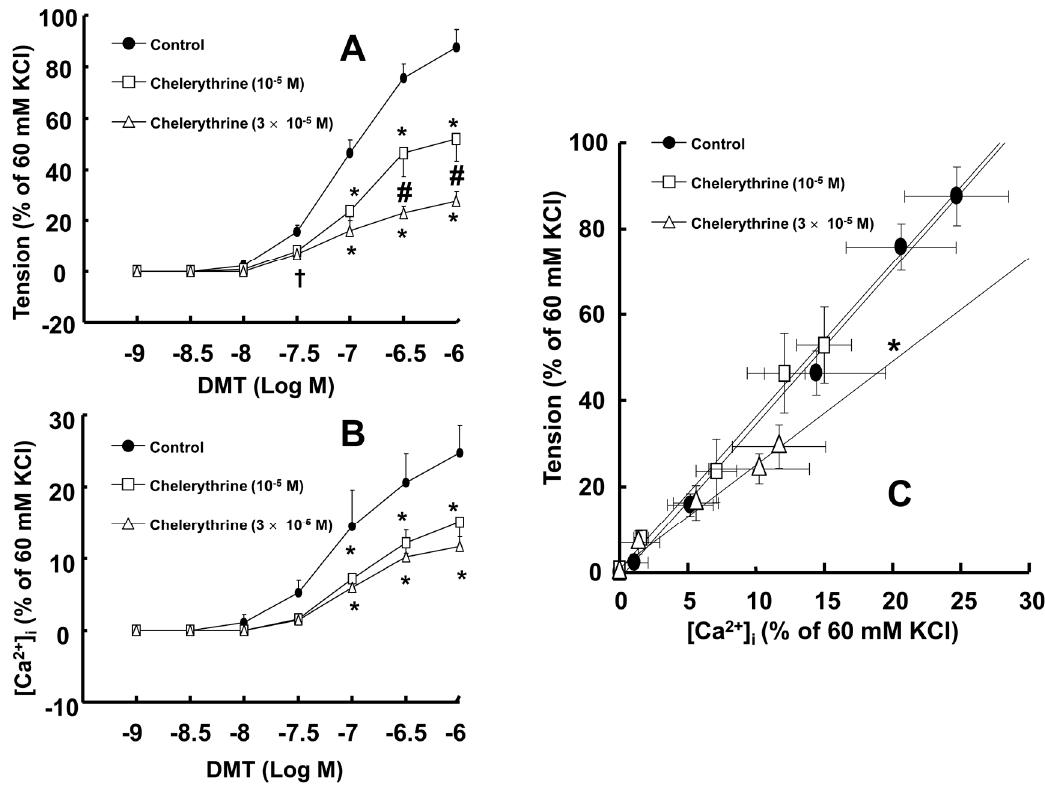
Figure 3. Effects of the cumulative addition of dexmedetomidine (DMT, 10 − 9 to 10 − 6 M) on muscle tension ( A ) and intracellular calcium concentrations ([Ca 2+ ] i ) ( B ) in the absence or presence of 10 − 5 M or 3 × 10 − 5 M chelerythrine in endothelium-denuded rat aortas. A value of 100% represents the 60 mM KCl-induced [Ca 2+ ] i increase and muscle tension measured before washout with Krebs solution; ( C ) The [Ca 2+ ] i -tension relationship was constructed by the cumulative addition of DMT (10 − 9 to 10 − 6 M) in the absence or presence of chelerythrine. Each point represents the mean of five experiments, and the SD is shown by both the vertical and horizontal bars. The effects of chelerythrine on the DMT concentration-response curves were analyzed using two-way repeated measures analysis of variance (ANOVA) followed by Bonferroni’s post hoc test. The slopes of the [Ca 2+ ] i -tension curves induced by DMT were calculated using linear regression, and the effect of chelerythrine on the slope was analyzed using one-way ANOVA followed by Bonferroni’s post hoc test. ( A , B ): * p < 0.001 and † p < 0.05 versus control. # p < 0.001 versus 10 − 5 M chelerythrine; ( C ): slope; * p < 0.01 versus control.